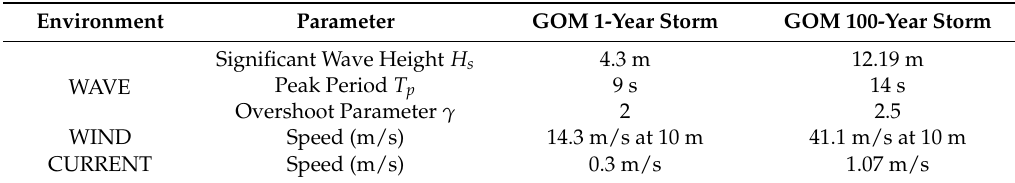
Table 4. Environmental Conditions.